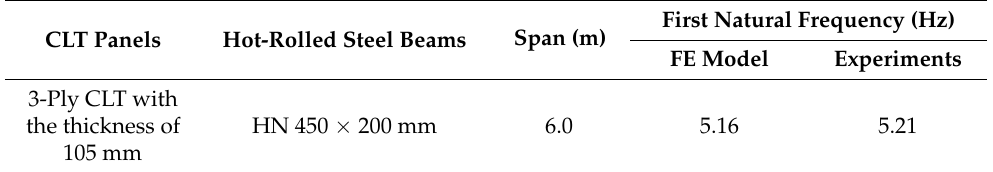
Table 9. The floor details and frequency results of STC floors studied by Wang et al. [45]. A mass of 0.5 ton was applied to represent the presence of the furniture.